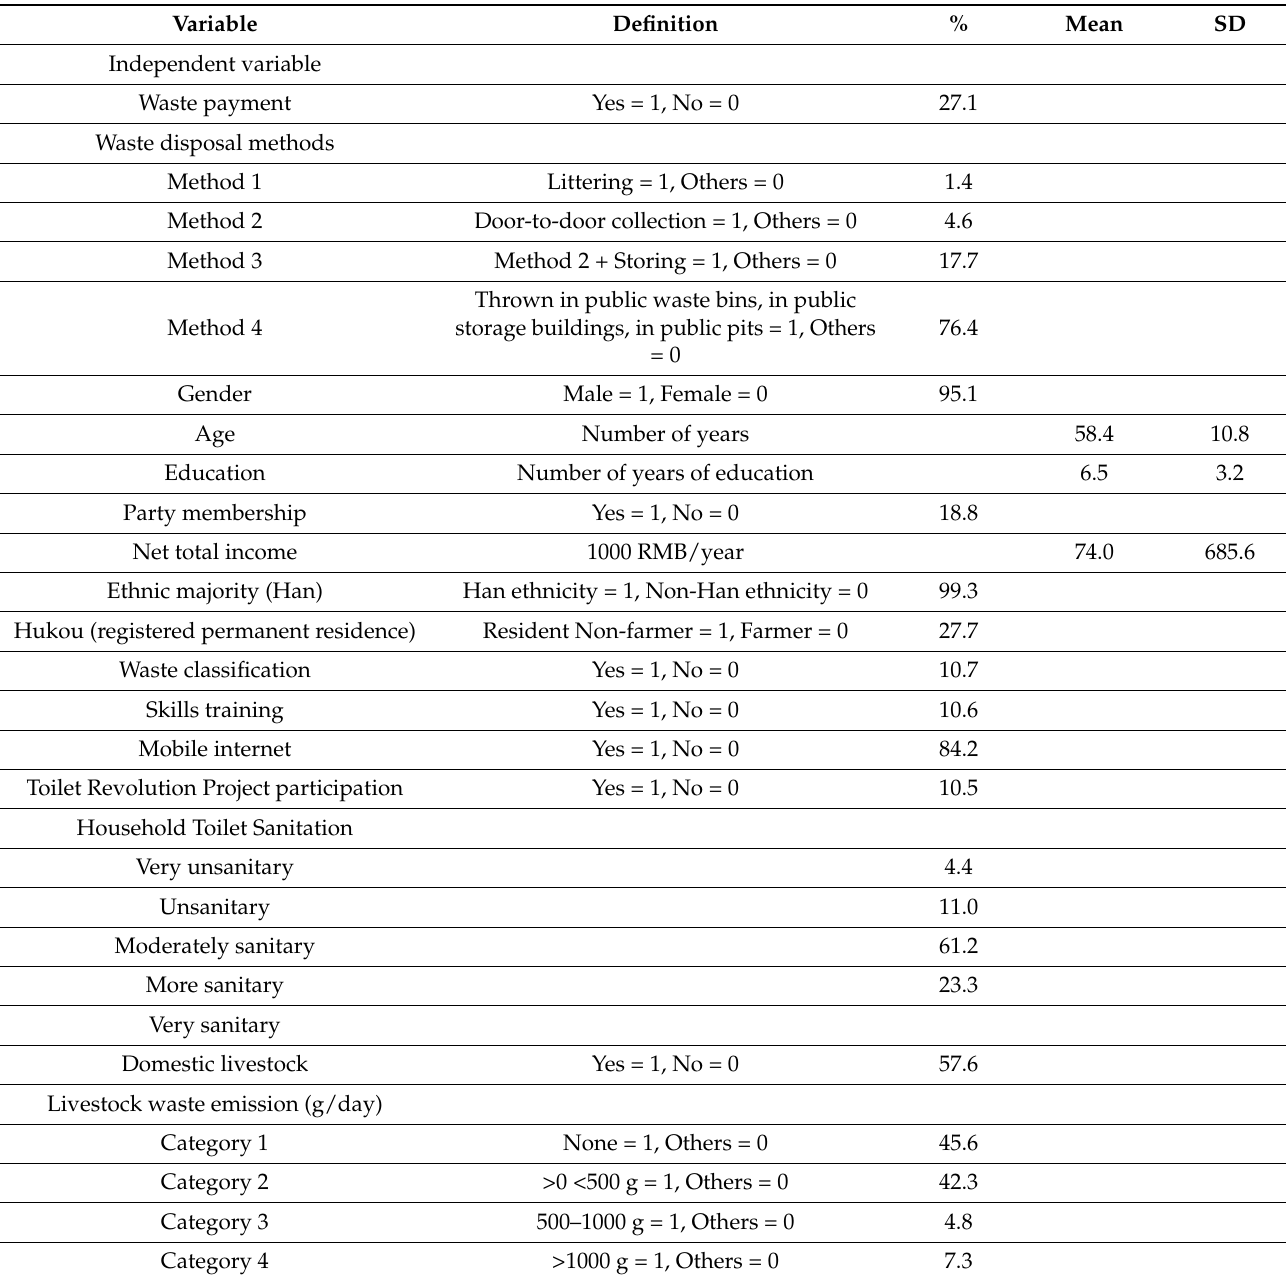
Table A1. Descriptive